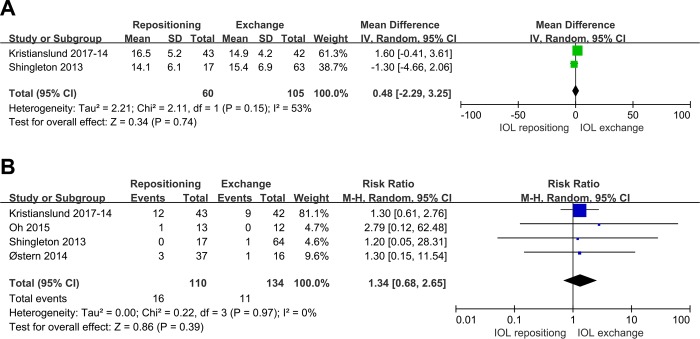
Comparison of IOL repositioning and IOL exchange in terms of IOP.(A) Postoperative IOP. (B) Increase in postoperative IOP relative to perioperative IOP.